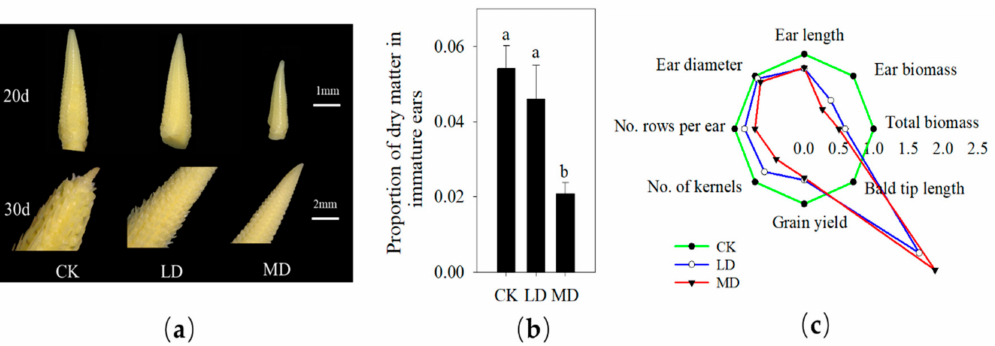
Figure 2. Development of female inflorescence and agronomic traits changes of ears in response to drought stress. ( a ) Contrasting sizes and di ff erentiation of the control and drought-treated plants at 20 and 30 DAD. ( b ) Proportion of dry matter in immature ears at 30 DAD. ( c ) Radar chart showing changes in yield traits for mature maize plants grown under well-watered (CK), light drought (LD), and moderate drought (MD) conditions. ( b ) and ( c ) were calculated with 15 and 10 biological replicates sampled for each